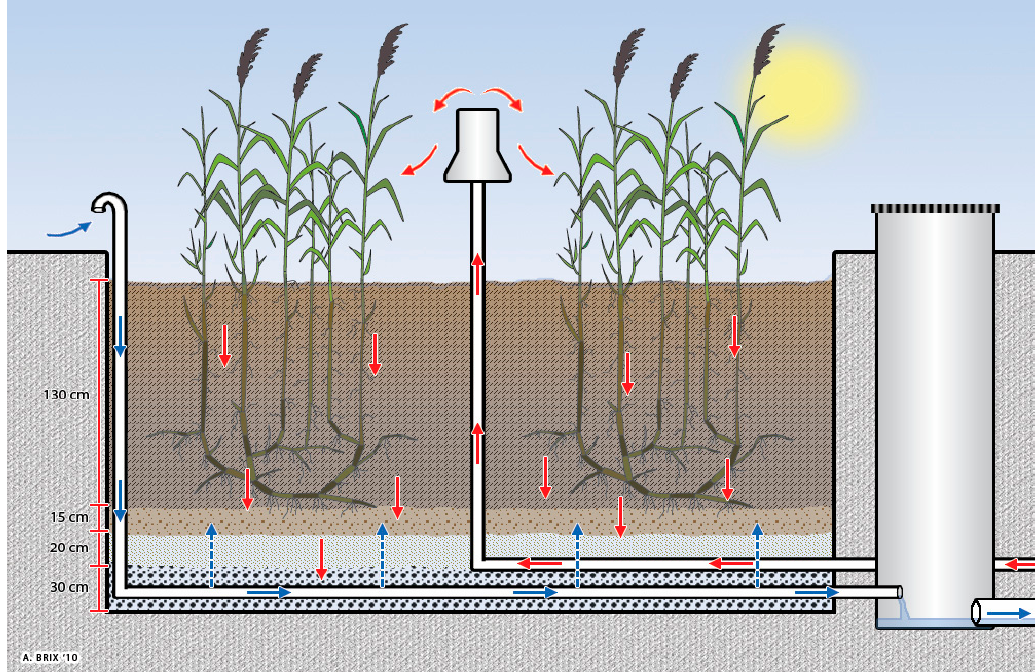
Figure 1. Diagram of a typical Sludge Treatment Reed Bed. The bed includes an impermeable basin to host the bed, plants, several layers of specific types of gravel, sand, and soil, a distribution system with vertical standpipes, and a drainage system with efficient air-exchange via ventilation pipes extending into the atmosphere (Drawing by Anton Brix).